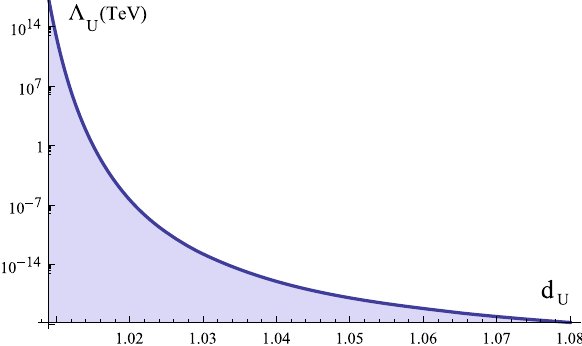
Fig. 2 Upper bound on (cid:8) U , the energy scale of scalar unparticles, as a function of the scale dimension, d U , where we have taken the coupling constant κ s = 1 and the other parameters as the ones previously